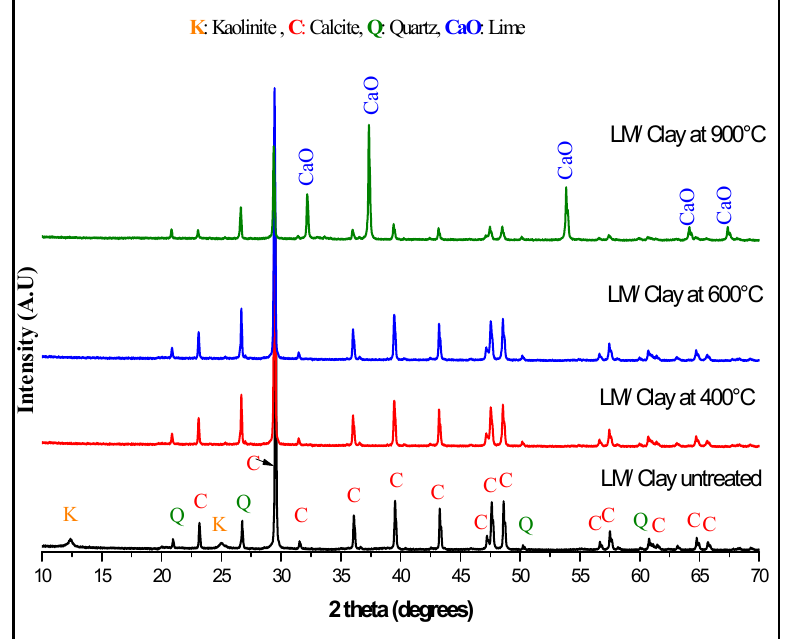
Figure 2. X-ray diffraction patterns of untreated limestone/clay mixture and heat-treated mixture at Figure 2. X-ray di ff raction patterns of untreated limestone / clay mixture and heat-treated mixture at different temperature. di ff erent